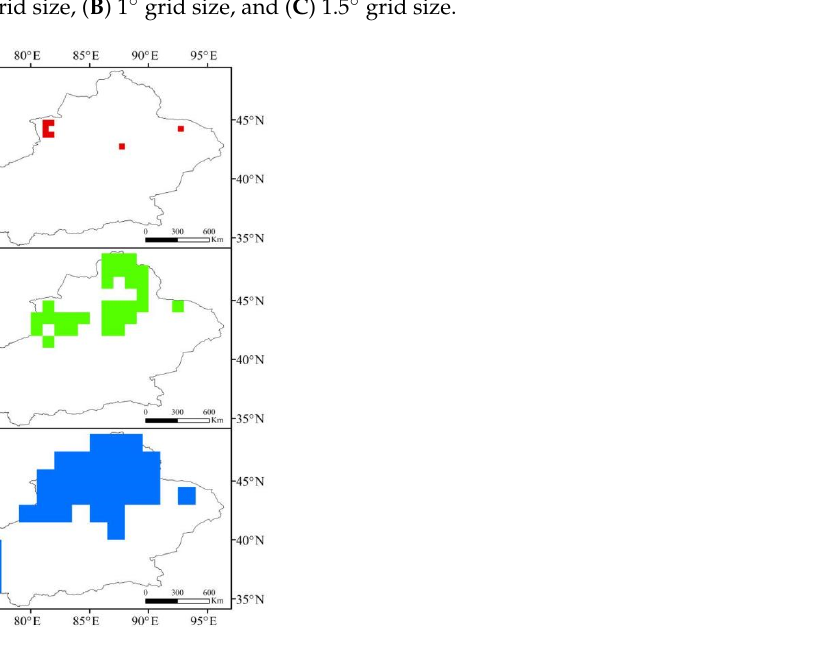
Figure 5. AOEs obtained for Tenebrionidae by EA analysis using three different cells in Xinjiang, China: ( A ) 0.5° grid size (red shadows); ( B ) 1° grid size (green shadows); and ( C ) 1.5° grid size (blue shadows).